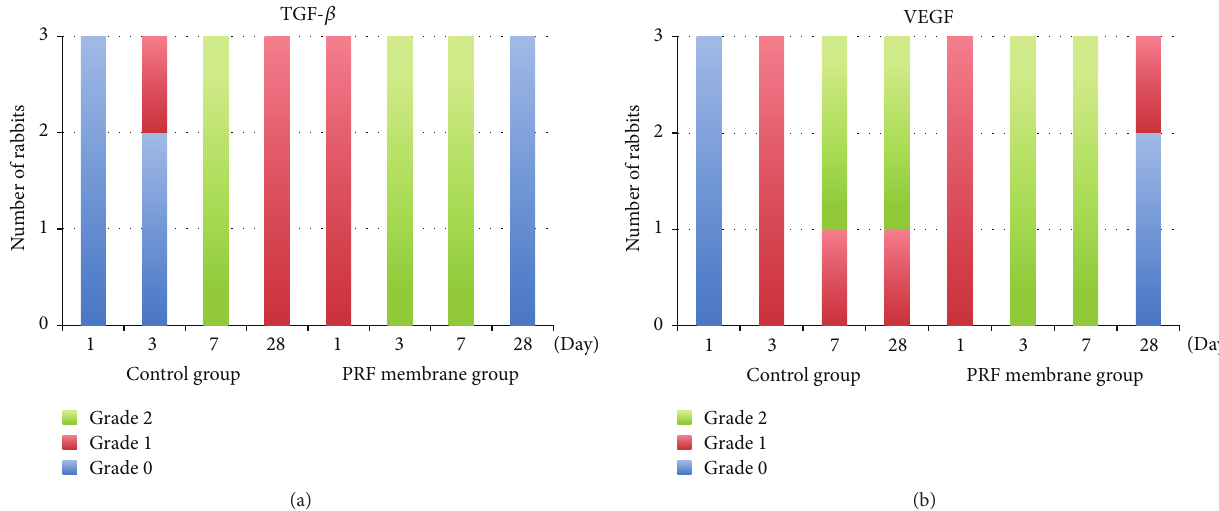
Figure 8: Comparison of the staining intensity of TGF- 𝛽 and VEGF. (a) Histogram of the TGF- 𝛽 staining. (b) Histogram of the VEGF